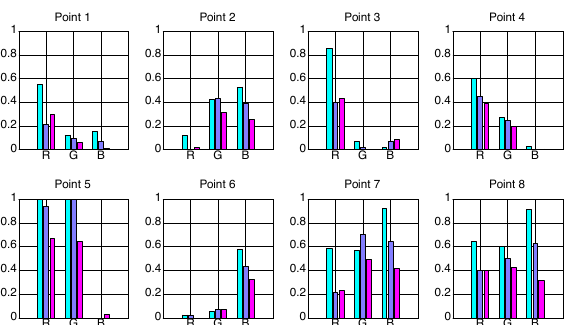
Figure 6. Calculated RGB values from spectra at chosen pixels of reference (cyan), 2D framelet reconstructed (purple) and 3D wavelet reconstructed (pink) of the “Color Checker"